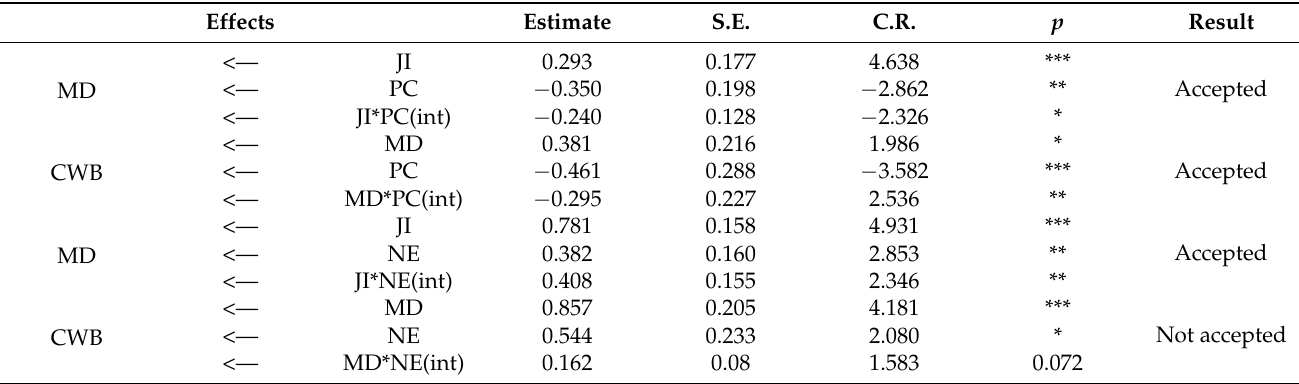
Table 3. Bootstrap results for the moderating effects.